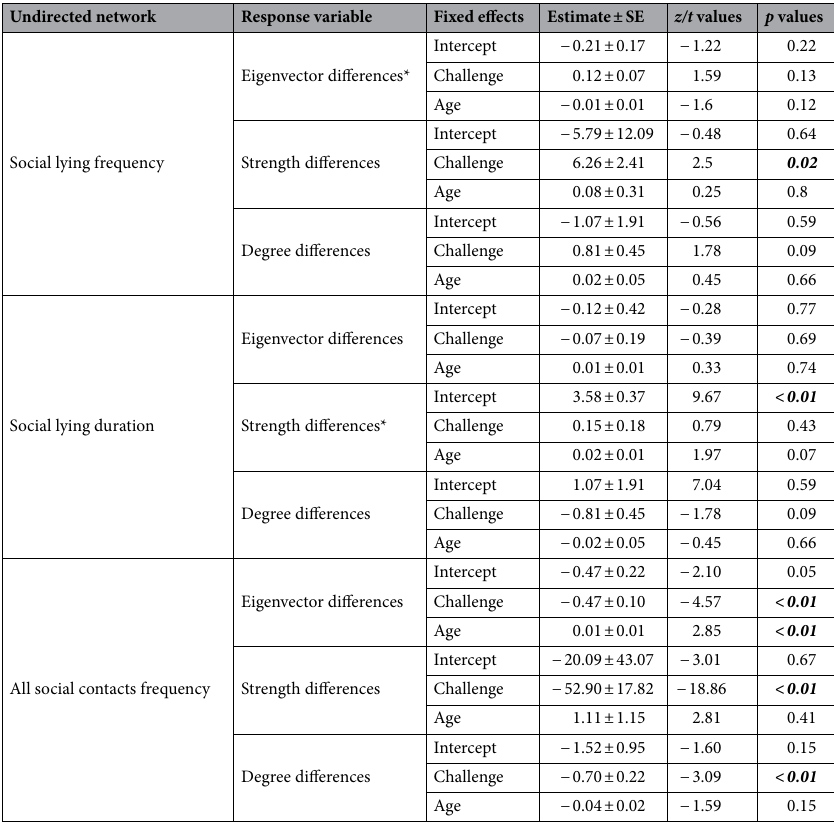
Table 3. Results of linear mixed-effect models for undirected networks of bull calves (35.9 ± 8.8 days of age) housed in groups (6 calves/pen): differences in centrality measures between baseline and challenge day, testing the main fixed effects of calves exposed to an experimental challenge model (inoculation with M. haemolytica) or a sham procedure (inoculation with sterile saline) and age, random effect (Pen): coefficient estimates, standard errors, t -test and p -values. Significant values are in [bold]. *Denotes Log 10 transformed